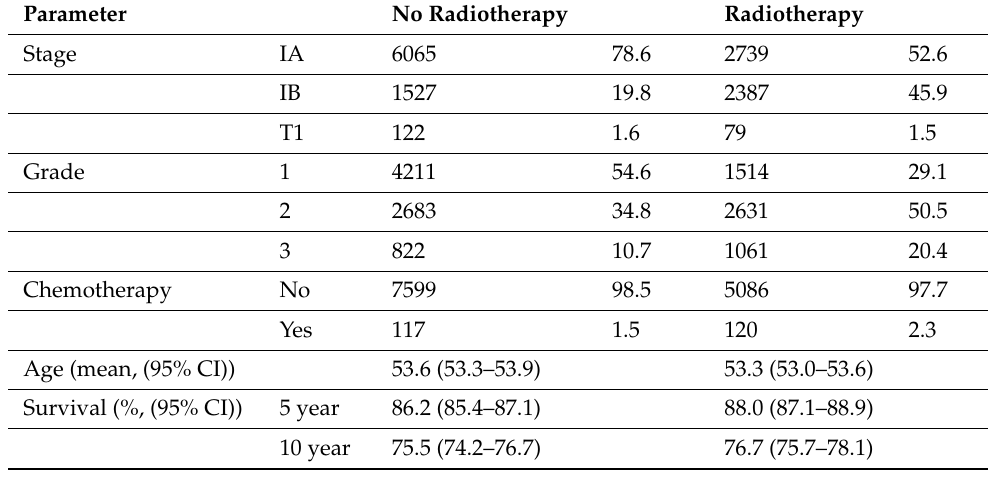
Table 1. Basic characteristics.